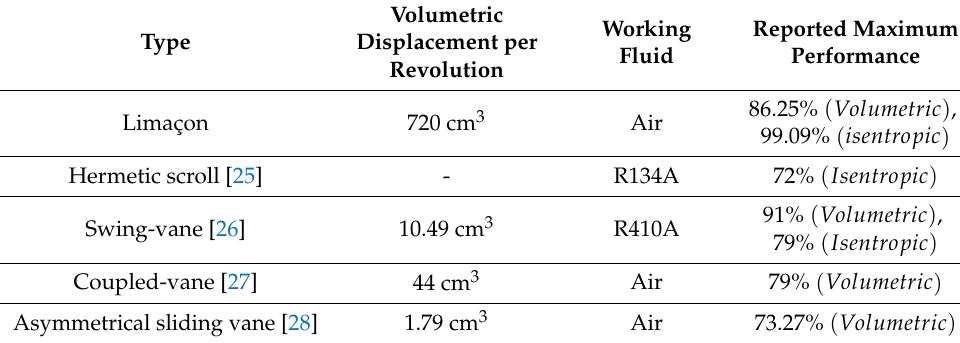
Figure 9. Performance of the optimized compressor under different outlet pressure (at 1400 rpm ). Table 5. Performance comparison of other types of rotary compressors.